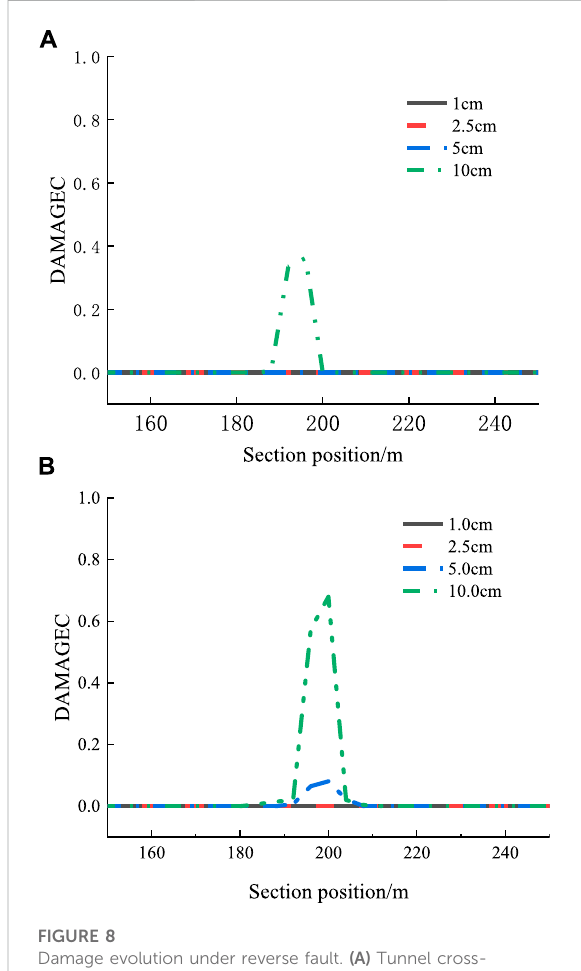
FIGURE 8 Damage evolution under reverse fault. (A) Tunnel cross- section DAMAGEC at the foot of the arch (B) Tunnel cross-section DAMAGEC at the arch waist.